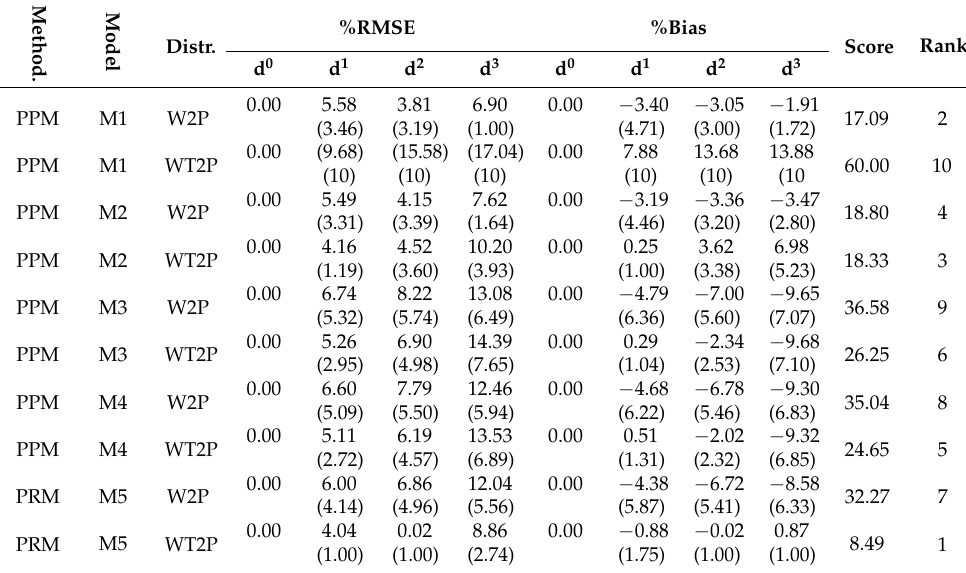
Table 6. Evaluation of the considered methods and functions applied to the test